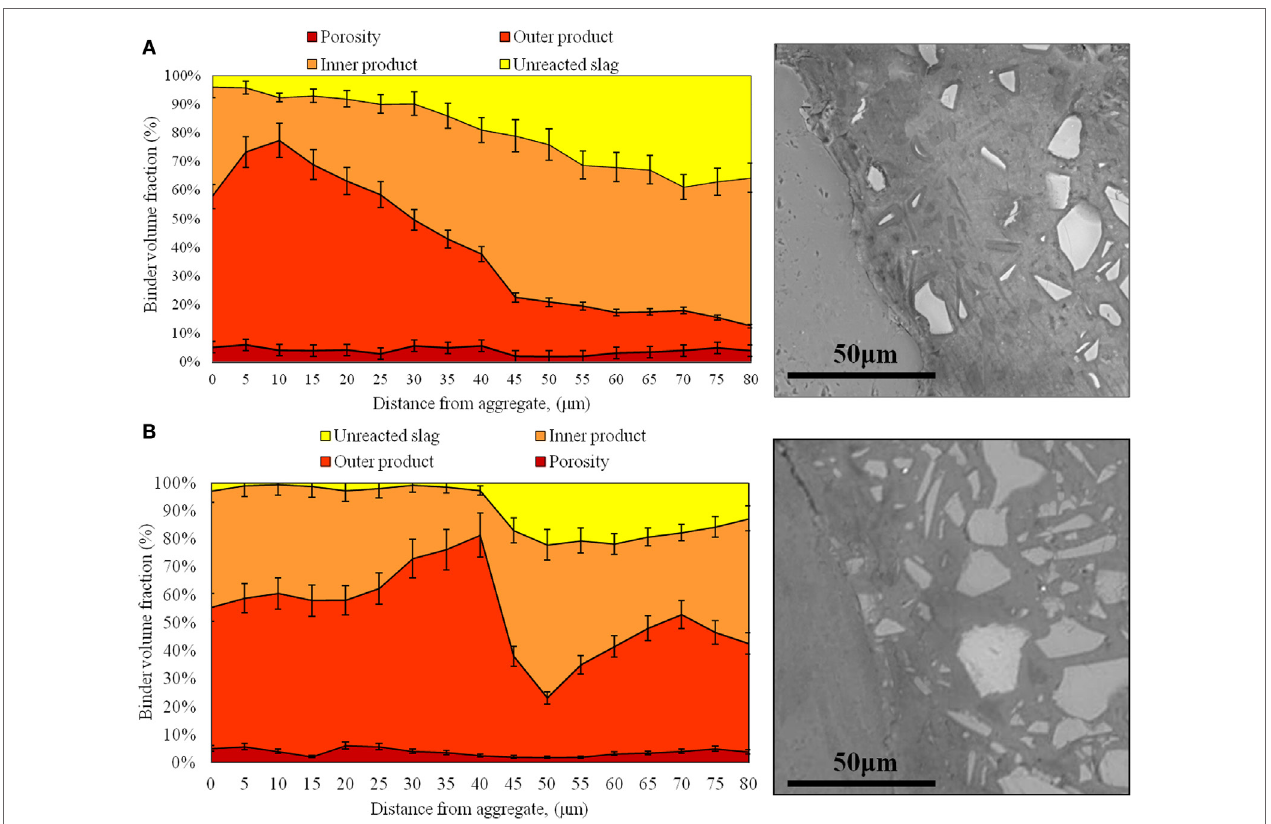
FigUre 4 | characterization of the interfacial properties of the coarse sand mortars at 28 days of age: (a) high-alkali aas formulation and (B) low-alkali aas formulation